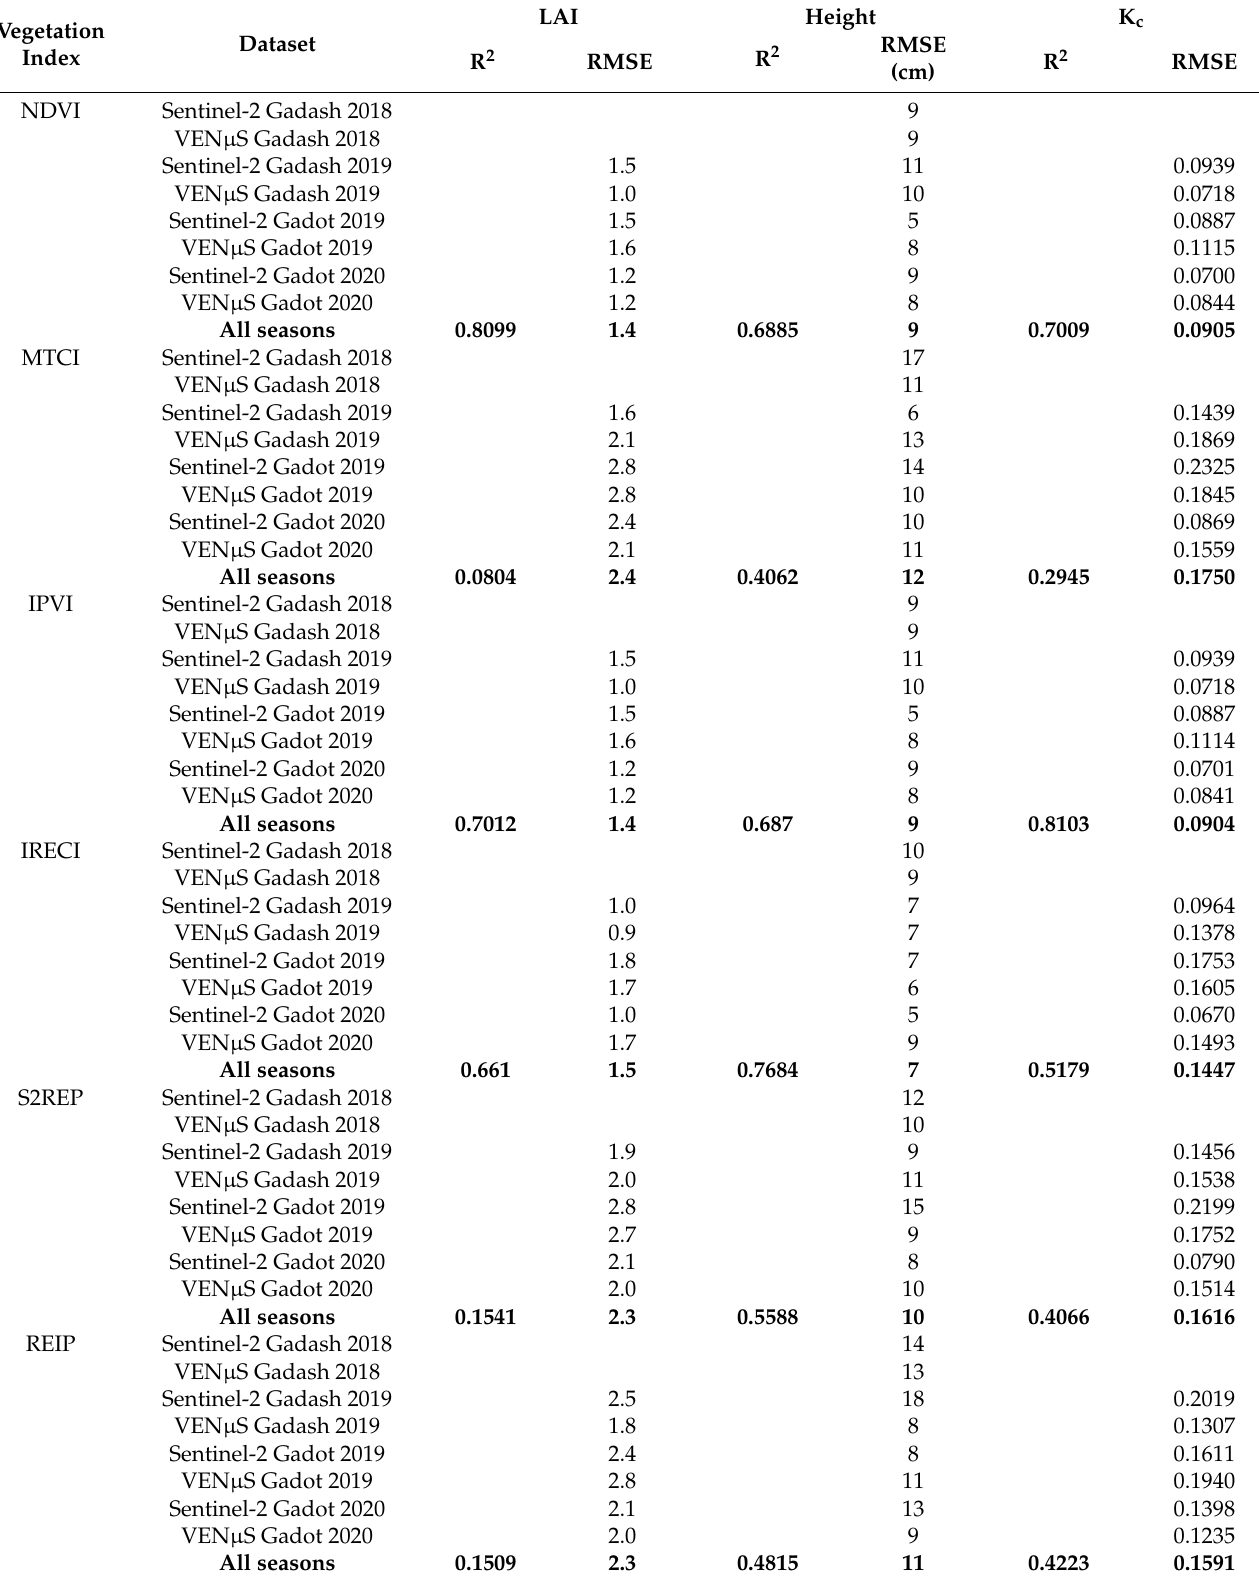
Table A3. Performance statistics of S2/V NT -based LAI, Height, K c models. Performance statistics of better performing VIs can be found in Table